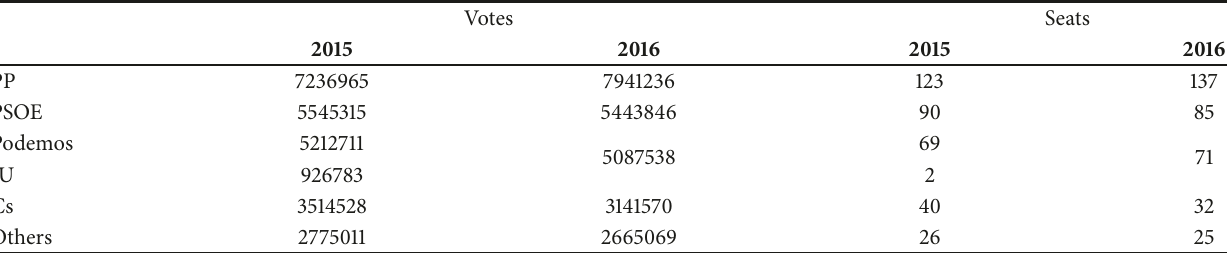
Table 1: Results of the Spanish general elections of the 20th of December 2015 and the 26th of June 2016. Podemos and IU are together in 2016 because they formed a coalition called